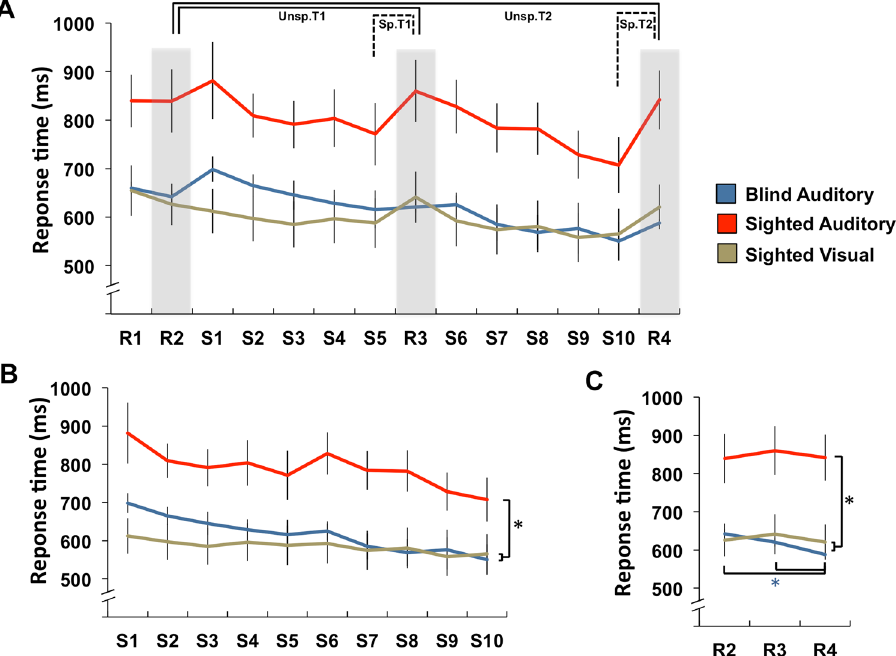
Figure 1. ( A ) Mean response time in milliseconds (ms) for each block of the SRTT, “S” and “R” denote sequence and random blocks respectively. T1 = first phase; T2 = last phase. Unsp. = non-specific learning; Sp. = specific learning ( B ). Mean response time for sequence blocks (S1–S10). Sequence ( B ) and random blocks ( C ) are shown separately for visualisation purpose. Error bars show standard error of the mean. * p < 0.05.